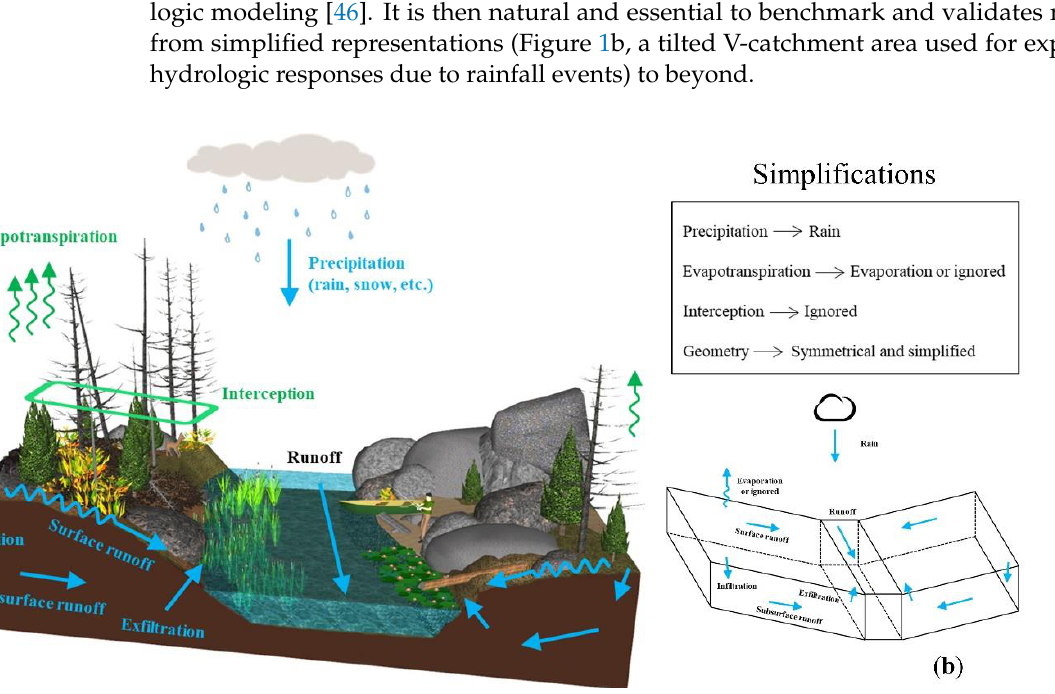
Figure 1. From complexity to simplicity: realistic and idealized watersheds: ( a ) conceptual model of the real-world hydrologic cycles; ( b ) an idealized tilted V-catchment model. the real-world hydrologic cycles; ( b ) an idealized tilted V-catchment